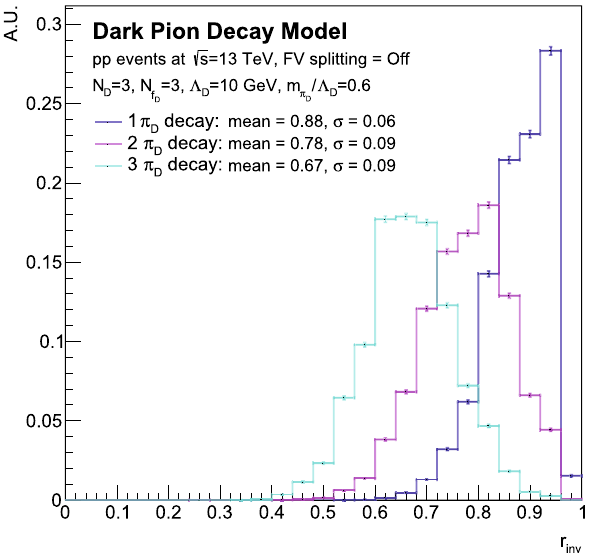
Fig. 36 Comparison of r inv for 1-, 2- and 3- π D decay models